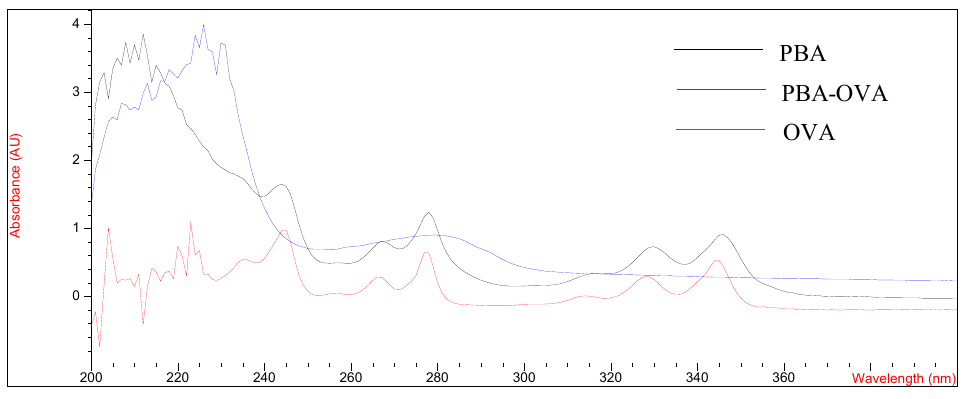
Figure 2. UV spectrum of OVA, PBA and PBA-OVA.